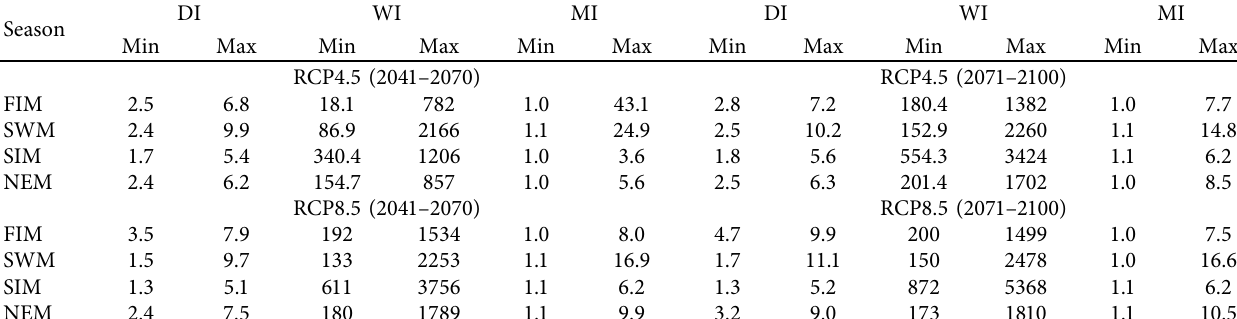
Table 4: Mid and far-future indices (2041–2070 and